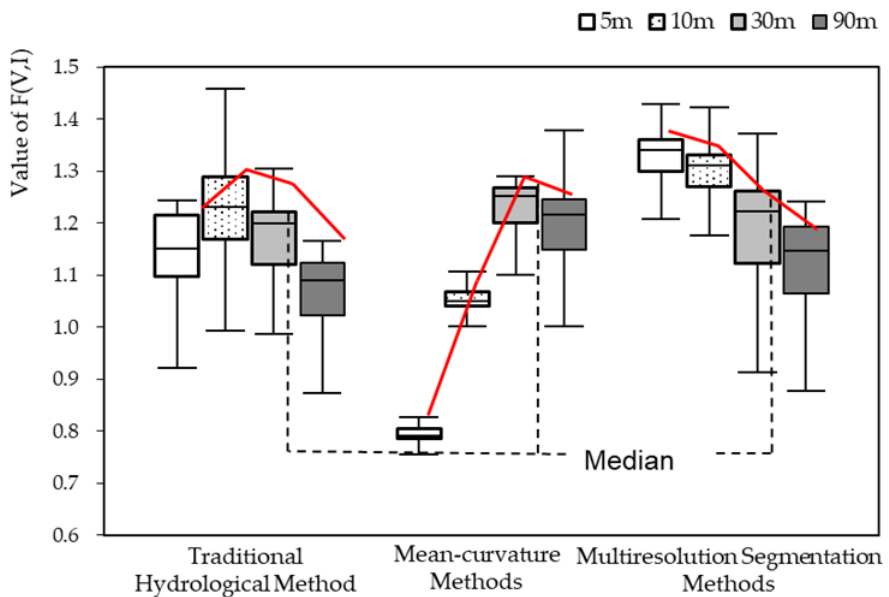
Figure 8. Variation in F ( V , I ) values against different DEM resolutions by the proposed segmentation method and previous